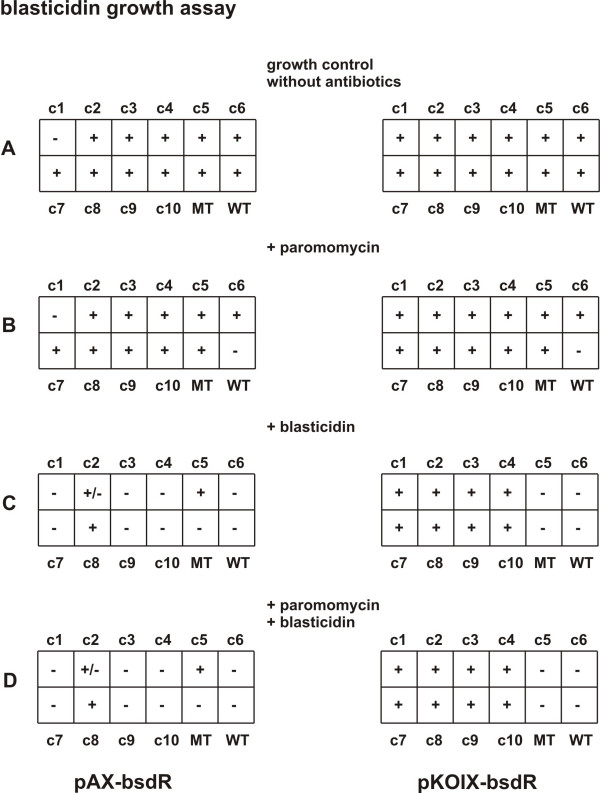
Blasticidin growth assay. We created a donor plasmid – pDL-bsdR – that encodes the blasticidin resistance gene under the control of the H4-1 promoter and the BTU2 terminator (see figure 5B). It has a similar structure as the previously described neo2 cassette (resistance against paromomycin) that is also present in the here used acceptor plasmids pAX and pKOIX. Using the Cre-dependent recombinase we generated the expression plasmids pAX-bsdR and pKOIX-bsdR and transformed T. thermophila strains. Blasticidin resistance assay: left column: clones of cells transformed with pAX-bsdR, rightcolumn: clones of cells transformed with pKOIX-bsdR. Several independent clones (c1 to c10) were tested for bsd resistance. As controls we used the wildtype strain 1868/7 (WT) and a mock transformant (MT) that only carried the neo2 resistance gene A: growth control of clones in SPP-medium without antibiotics; B: same clones as presented in A selected in SPP-medium with 400 μg/mL paromomycin after 5–10 days C: same clones as in B, but cultivated for 3–5 days in SPP-medium with 100 μg/mL blasticidin; D: identical clones as in B/C cultivated in SPP-medium for 3–5 with both antibiotics, paromomycin (400 μg/mL) and blasticidin (100 μg/mL). + strong growth of clones. +/- cells alive, less growing. - no growth, cells died within 2–3 days.